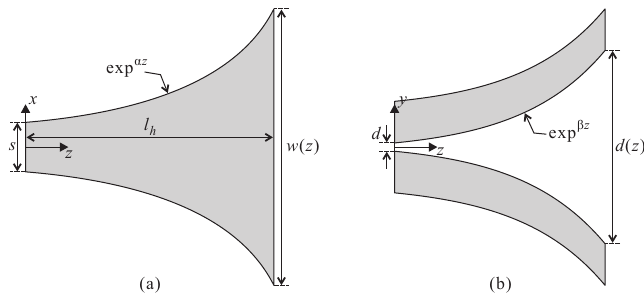
Figure 5. Cross-sectional views of the horn aperture: ( a ) xz -plane and ( b ) yz -plane.